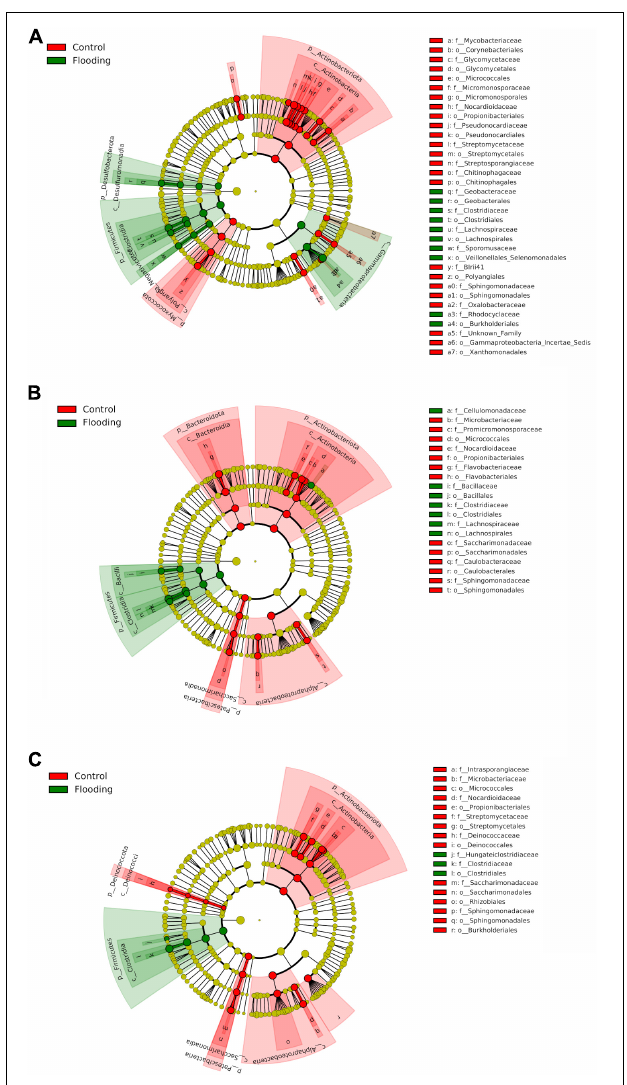
FIGURE 6 | LEfSe analysis at multiple taxonomic levels comparing root bacterial community structure in both control and flooding treatment at tillering (A) , booting (B) and flowering (C) . Cladogram illustrating the taxonomic groups explaining the most variation among root communities. Each ring represents a taxonomic level, with phylum (p_), class (c_), order (o_) and family (f_) emanating from the center to the periphery. Each circle is a taxonomic unit found in the dataset, with circles or nodes shown in colors (other than yellow) indicating where a taxon was significantly more